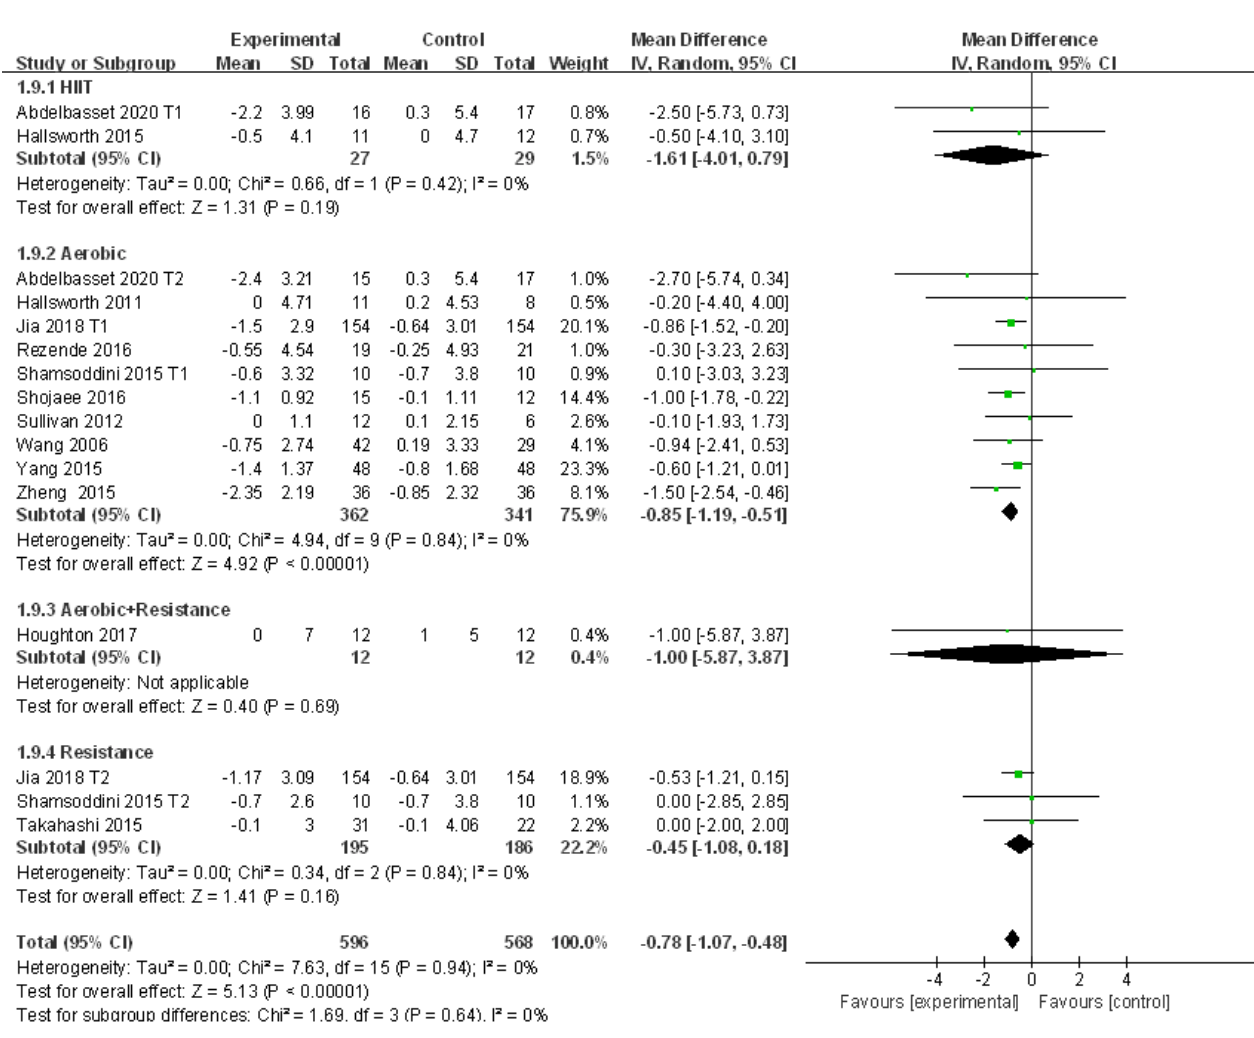
Figure 10. Subgroup analysis of different exercise styles on body mass index (BMI).